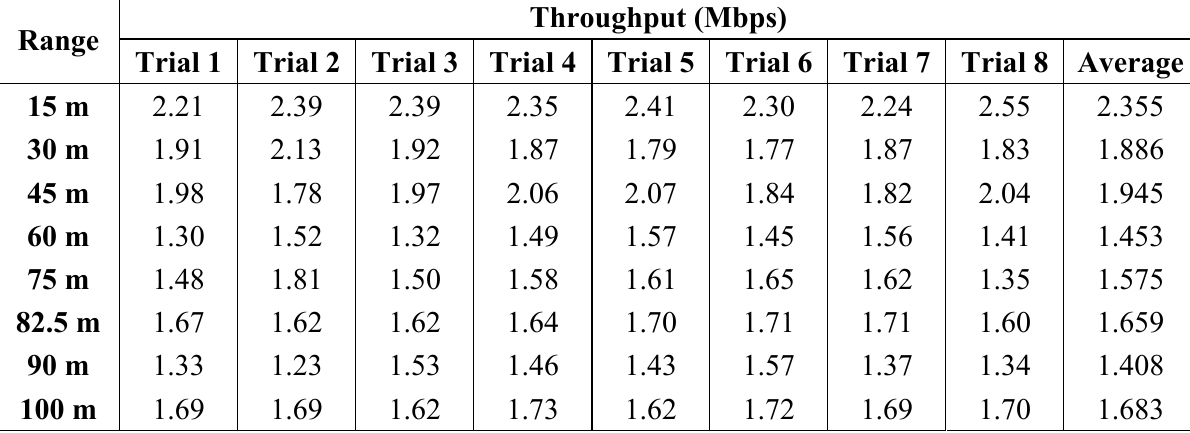
Table 3. The bandwidth results for the station 1–station 2 connection that uses different channels for the mesh and AP